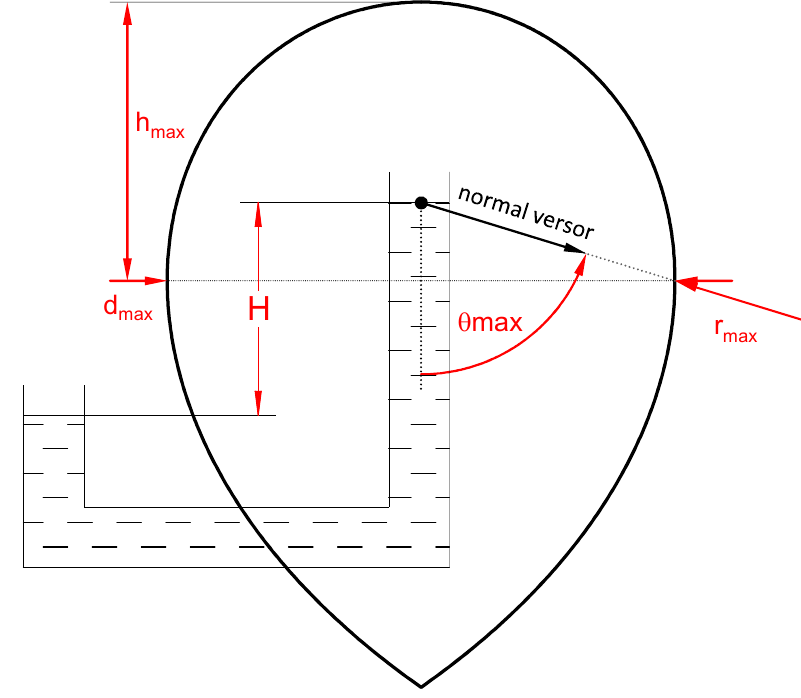
Figure 2. Shape of a bubble at creation if the ratio of the hydraulic head and capillary constant equals the square root of 8. The inner part contains a lighter gas, while the surroundings is a denser liquid, r max and θ max are the spherical coordinates at the widest diameter of the bubble.